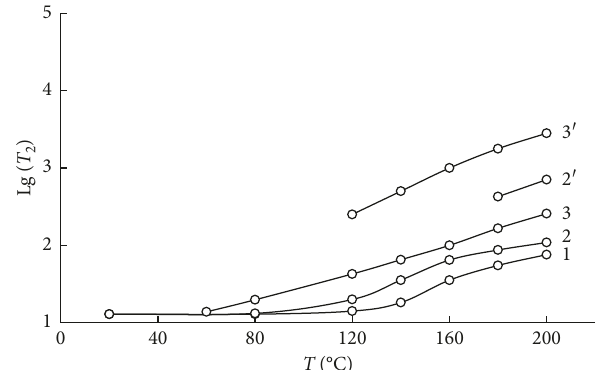
–c ) during the curing of ED- ). ′ ′ ′